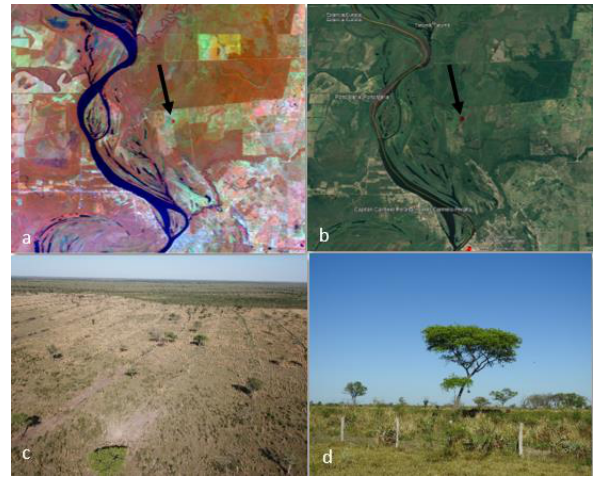
Figure 9. Deforested area of Pantanal in (a) a Landsat image (2019), which was confirmed by a field campaign (c, d). High resolution images from GoogleEarth® (b) contributed to the mapping process.